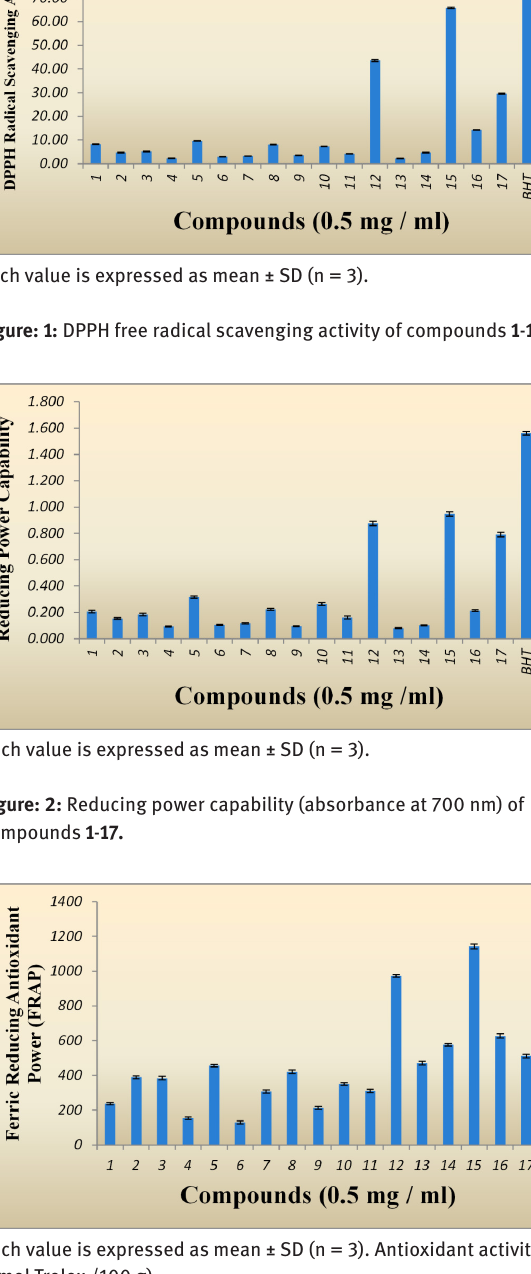
Table 1: The chemical structures of the products 1 - 17 . Cpd. Cpd.